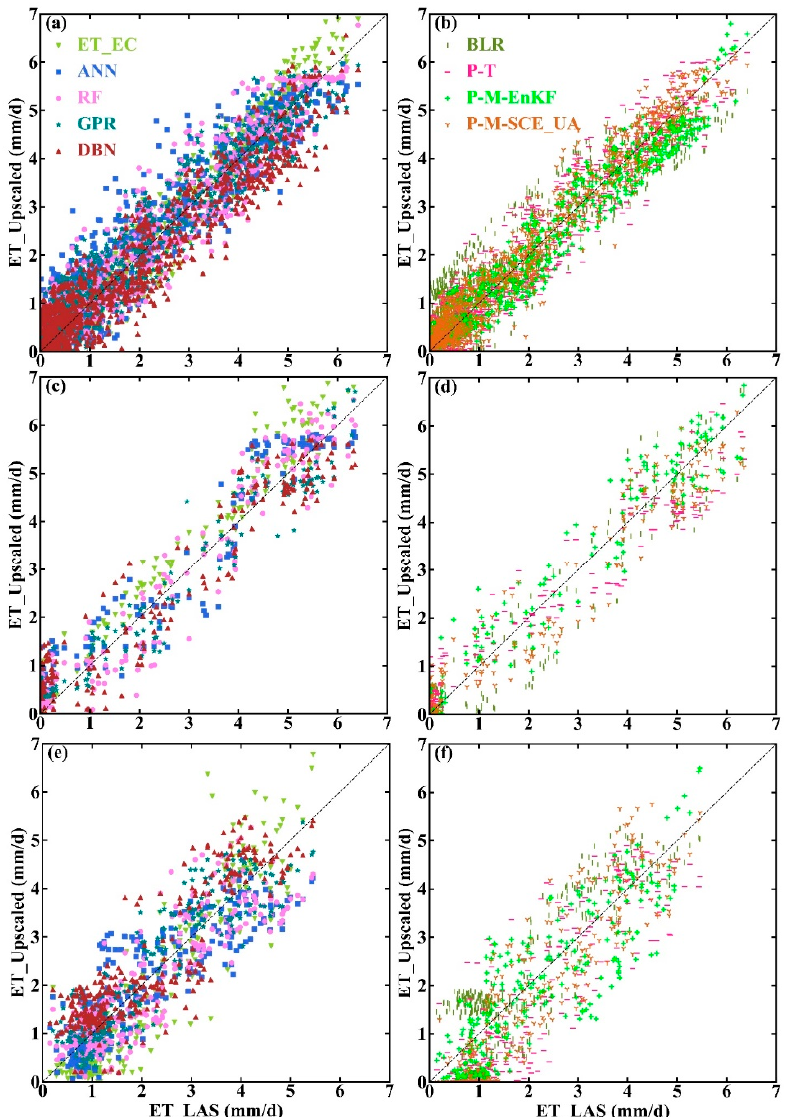
Figure 5. Comparison of upscaled ET obtained from eight upscaling methods and ET_EC with LAS measurements ( a , b ). Homogeneous underlying surfaces ( c , d ). Moderately heterogeneous underlying surfaces; ( e , f ). Highly heterogeneous underlying surfaces). Table 2. Statistics for comparison among the upscaled ET of eight upscaling methods, ET_EC, and LAS measurements.